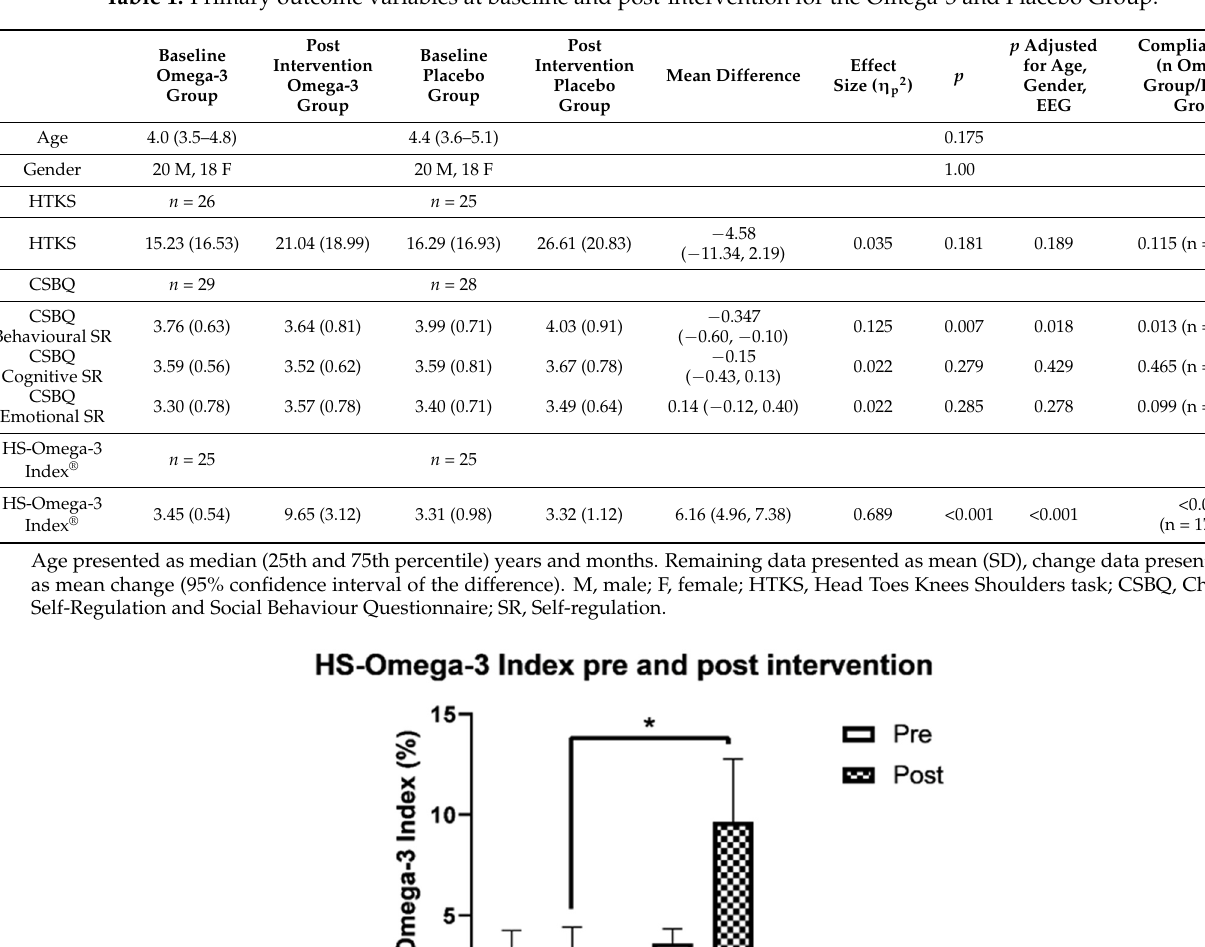
Table 1. Primary outcome variables at baseline and post-intervention for the Omega-3 and Placebo Group.